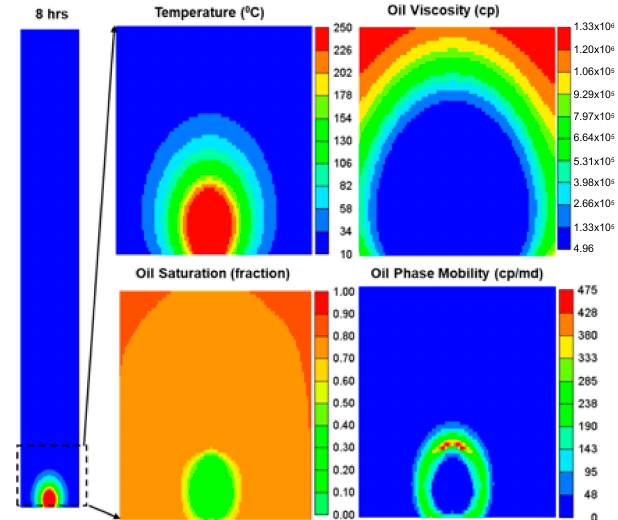
Figure 18. 2D images of the temperature, oil viscosity, oil saturation and oil phase mobility distributions in the VE model after 8 hours of steam injection. Zoomed in views are displayed of the region enclosed by the dashed black line square.